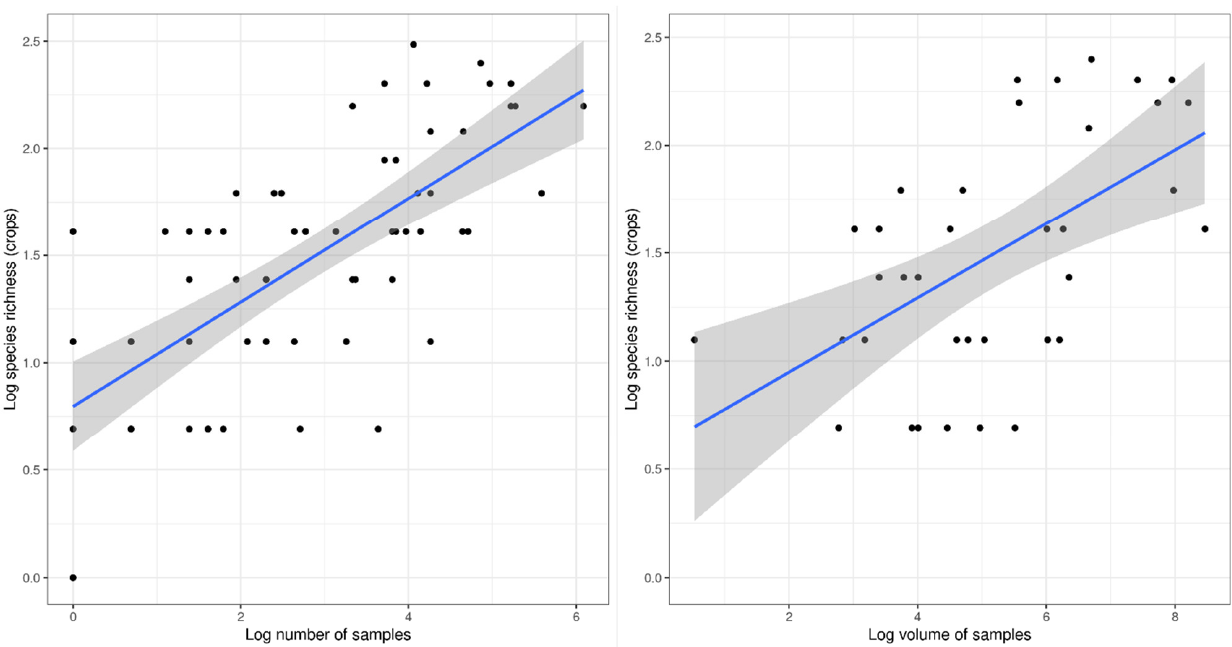
Figure 2. Correlation analysis of number ( left ) and volume ( right ) of samples to crop assemblage richness, using log-normalised values.